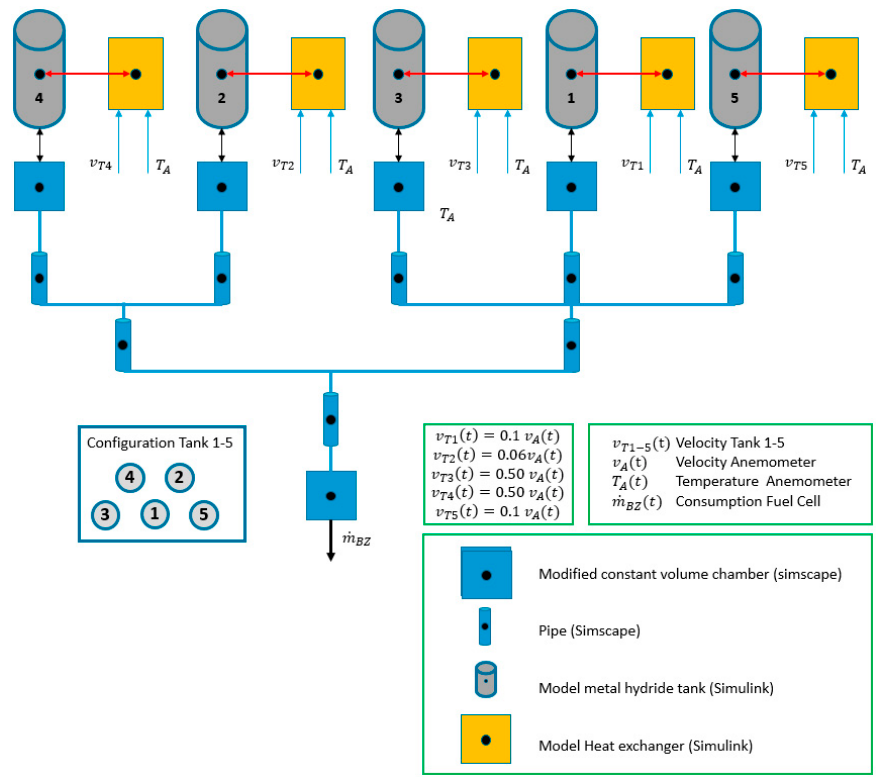
Figure 5. Implementation of MH2-Powerbank in MATLAB Simulink/Simscape: regulation of the air velocity.